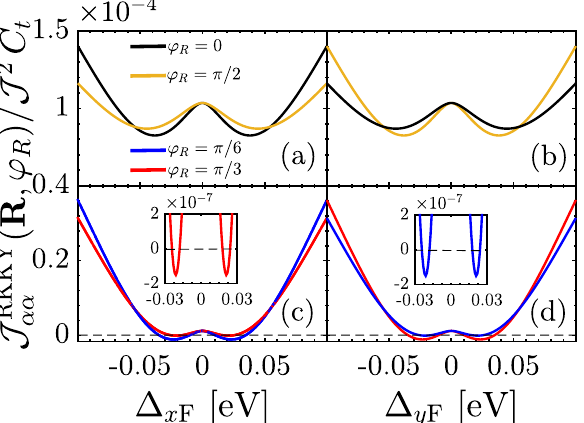
Figure 8. The behavior of the RKKY interaction J RKKY αα ( R , ϕ R )/ J 2 C t as a function of ferroelectric distortion potential ( a ), ( c ) (cid:31) x F and ( b ), ( d ) (cid:31) y F for four different complementary angels ϕ R between two magnetic 25 Å. The nontrivial behavior of RKKY response characterized by the decreasing and moments at R = increasing trends is present as long as the gapless and gapped states are